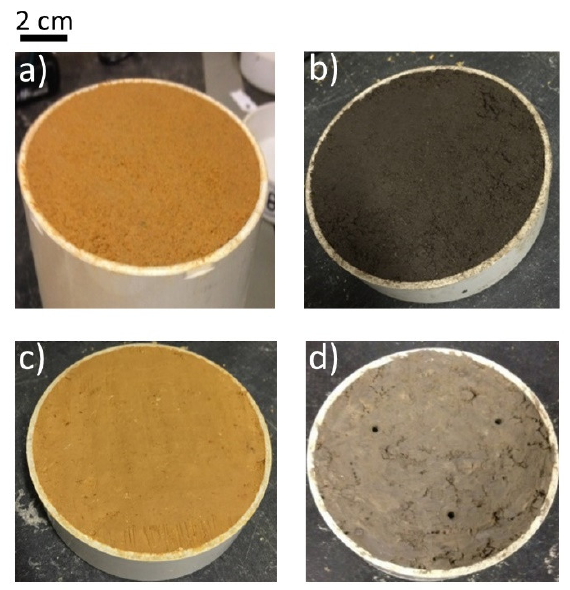
Figure 13. Typical examples of the prepared samples of: ( a ) Brighton Group Sand, ( b ) Silty Sand and ( c ) Camb Clay from the present study and ( d ) Basaltic Clay from Orangi, Withers, Langley and Narsilio [80].